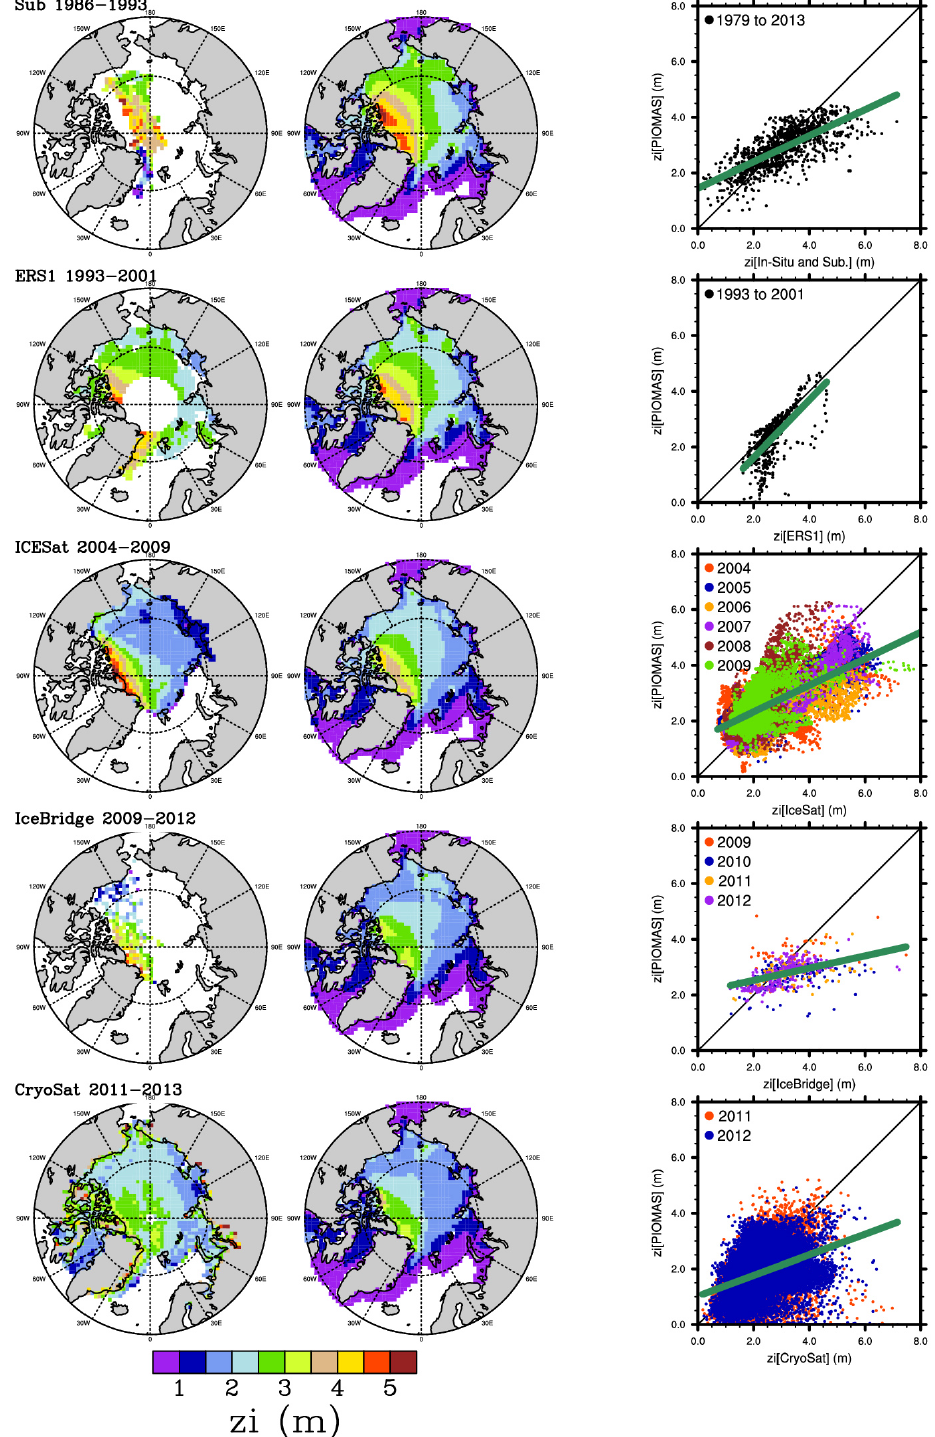
Figure 2. Comparison of submarine, ERS-1, ICESat, IceBridge and CryoSat-2 sea ice thickness (zi) fields (left column) for each campaign’s period of record, with ice thickness fields simulated by PIOMAS (middle column) and corresponding scatterplots (right column). PIOMAS fields are the average March thicknesses for the periods that correspond to observational records. In the scatterplots, individual years are shown in different colors, except for ERS-1, which was provided as a mean field for the entire time period.